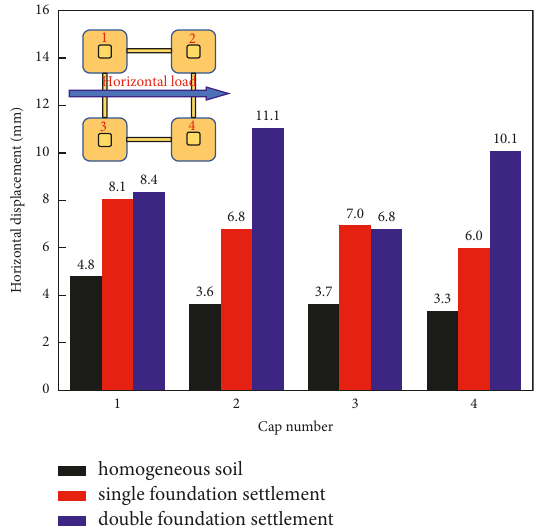
Figure 13: Horizontal displacement contrast diagram of